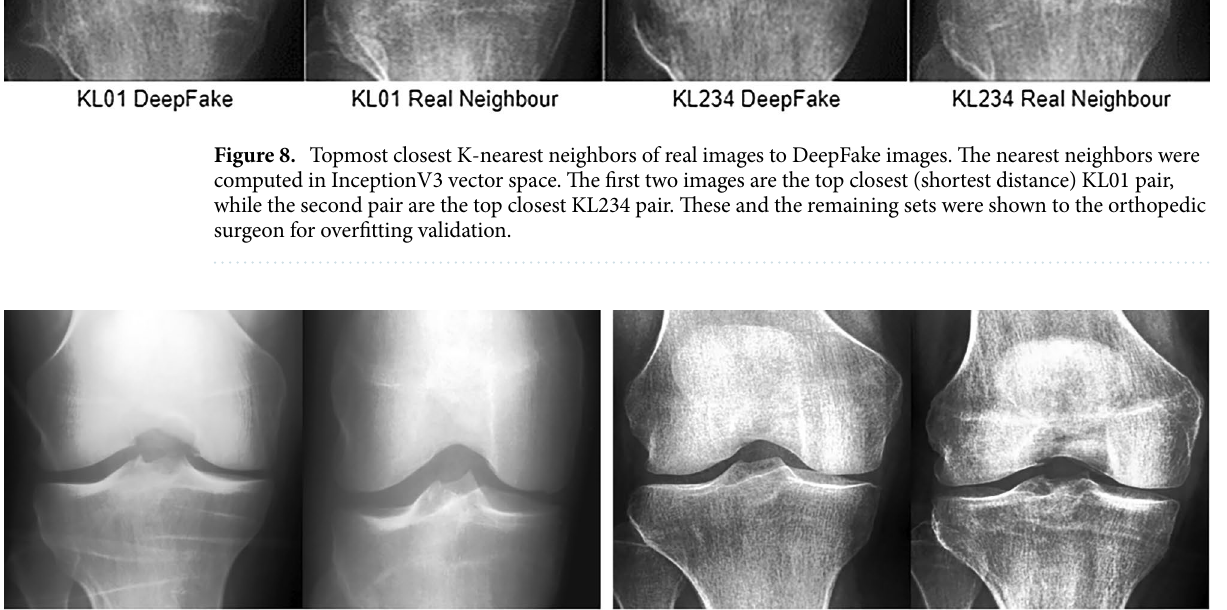
Figure 9. The first two images from the left are below the focus threshold , and the remaining two are above